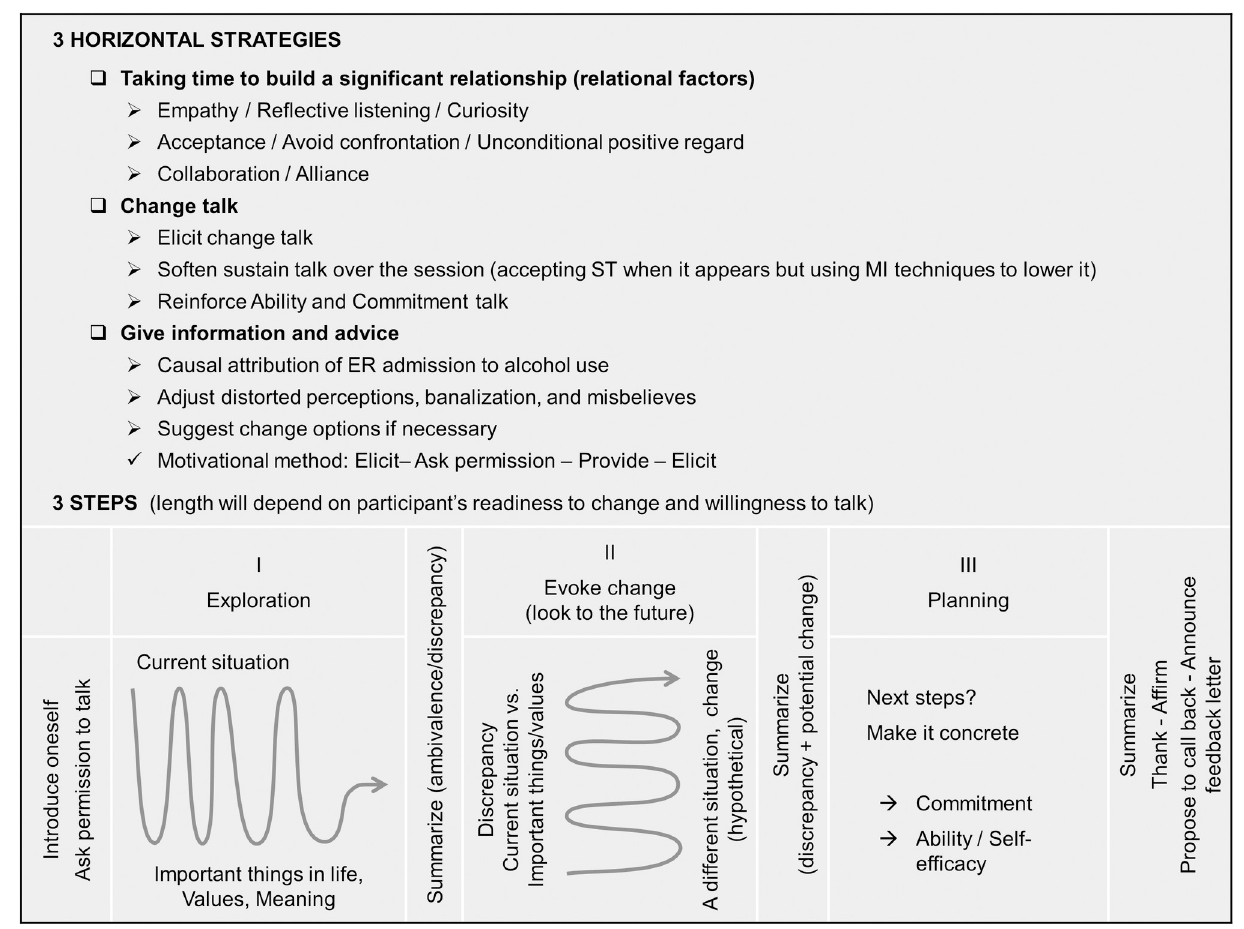
Fig 2. Schematic outline of the definitive intervention